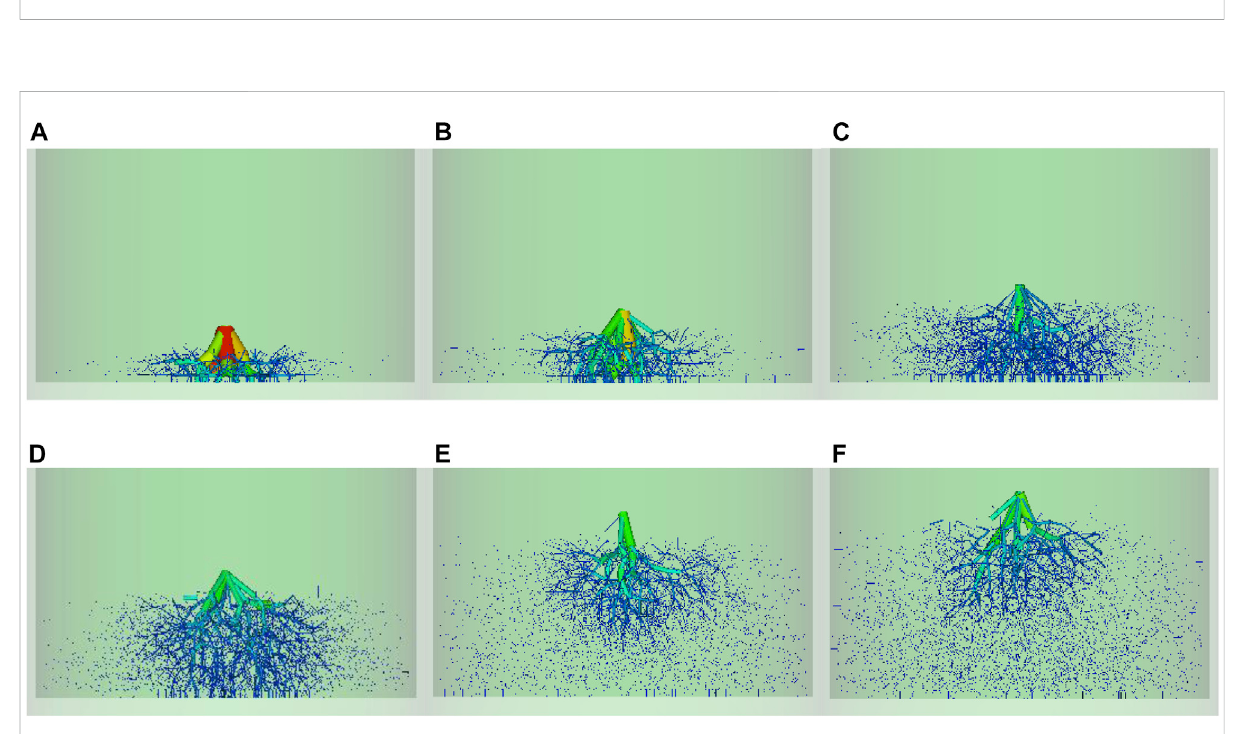
FIGURE 12 Comparison of the evolution of force chains with different thicknesses of the sphere-cylinder soil buffer layer at the same moment: (A) h = 15 mm; (B) h = 20 mm; (C) h = 27 mm; (D) h = 34 mm; (E) h = 48 mm; (F) h = 55 mm.